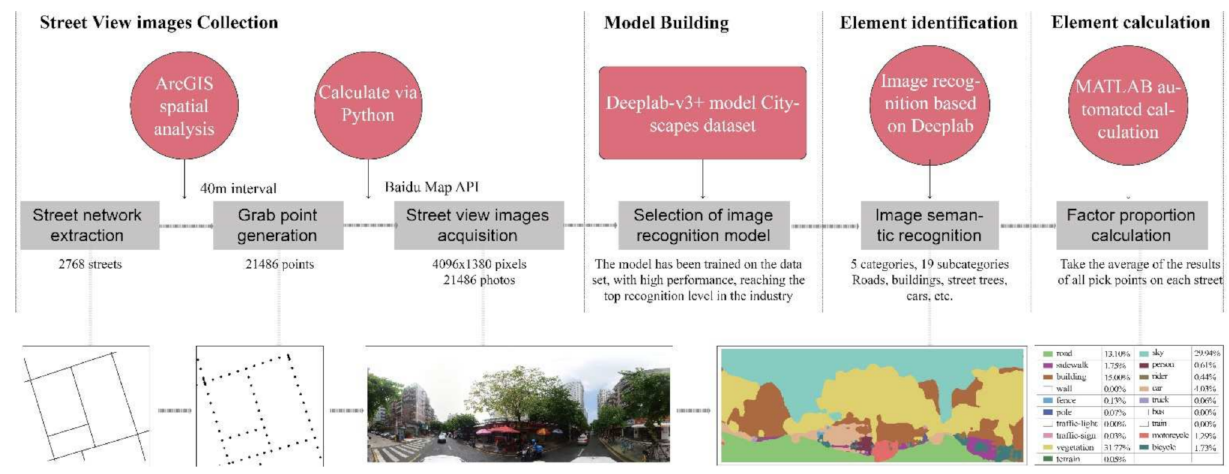
Figure 3. Collection and recognition process of street view